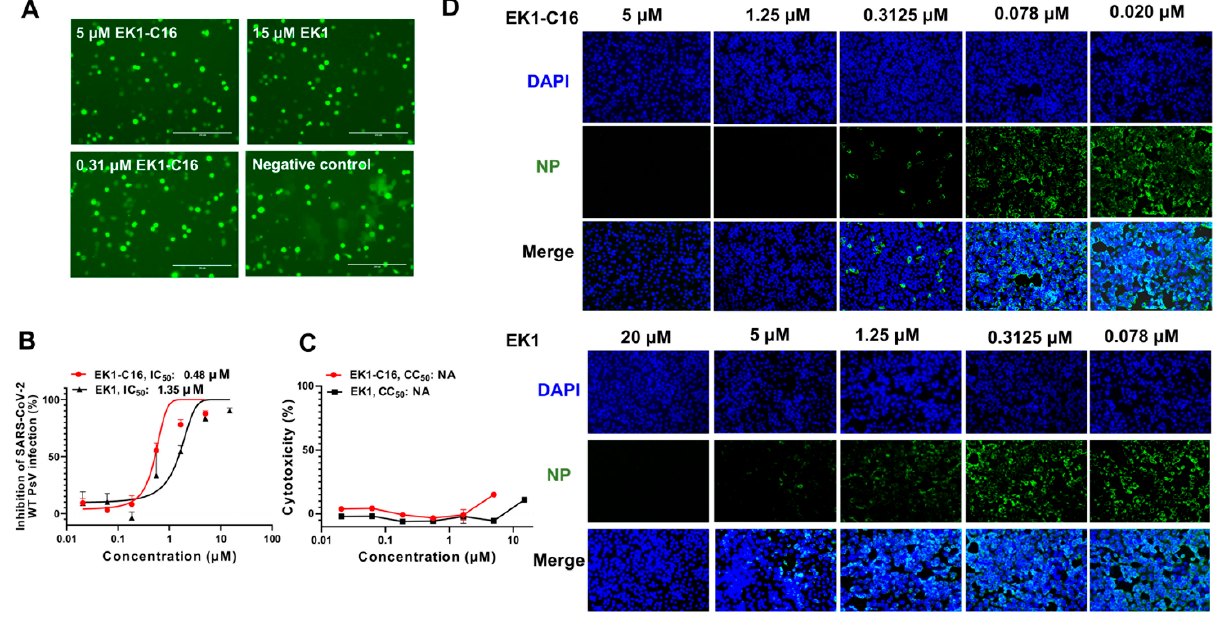
Figure 2. EK1-C16-mediated inhibition of SARS-CoV-2 infection. ( A ) EK1-C16-mediated inhibition of SARS-CoV-2 D614G S-meditated cell–cell fusion. ( B ) EK1-C16-mediated inhibition of SARS-CoV-2 WT (Wuhan-Hu-1) PsV infection. ( C ) Cytotoxicity of EK1-C16 to RD cells was tested by using a CCK-8 assay. ( D ) EK1-C16-mediated inhibition of authentic SARS-CoV-2 WT (nCoV-SH01) infection. Samples were tested in triplicate, and the experiment was repeated at least twice.